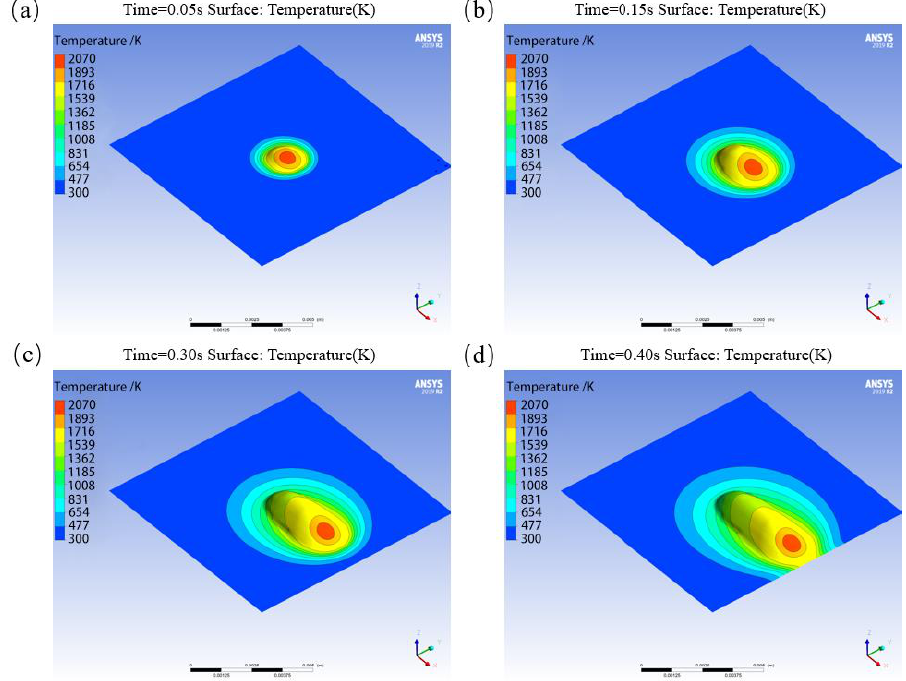
Figure 10. Temperature contour of single path deposition at different moments. ( a ) 0.05 s; ( b ) 0.15 s; ( c ) 0.30 s; ( d ) 0.40 s . ( c ) 0.30 s; ( d ) 0.40